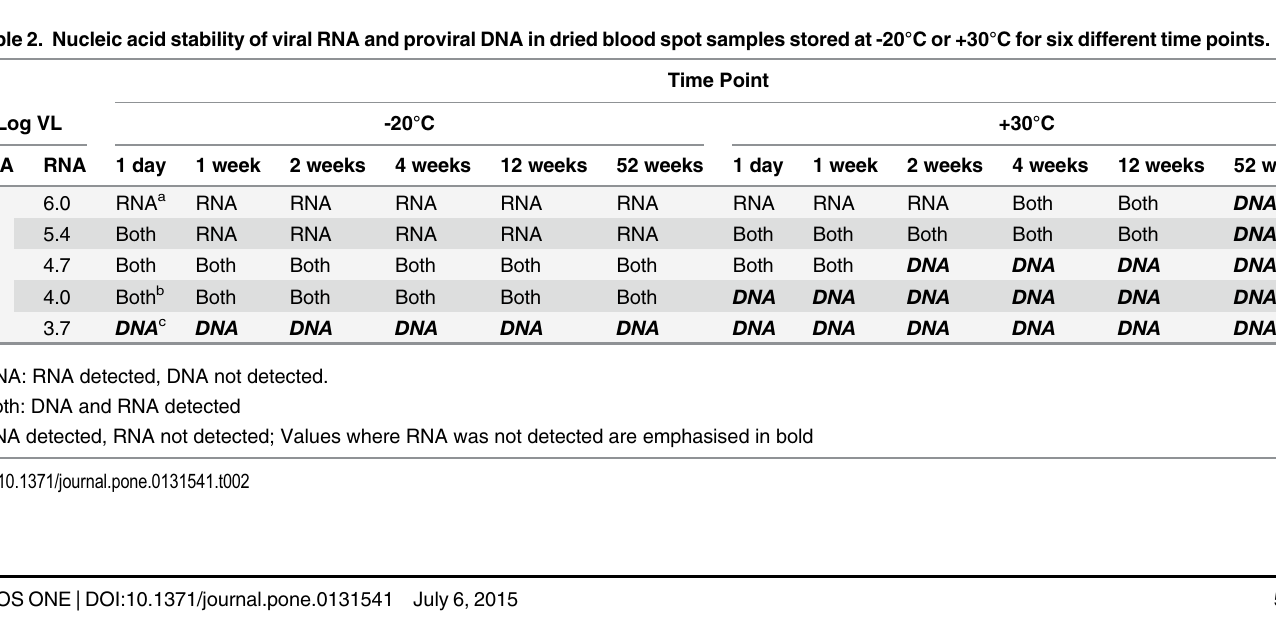
was no longer detectable at any of the concentrations tested (Table 2). To mimic field application of DBS collection, an experiment was performed in which short term storage at (elevated) room temperature was followed by storage at -20°C. Amplification of all DNA-RNA samples following sample storage for one day (baseline), one and two weeks at +30°C, followed by two weeks at -20°C, was successful for all samples. After four weeks stor- 3.0 RNA-only samples that age at +30°C, followed by two weeks at -20°C, none of the log 10 were stored at +30°C were amplified, whereas those stored at -20°C for the six weeks could all be successfully amplified. Genotyping of samples stored at +30°C for two weeks, followed by -20°C for another two weeks, demonstrated that the results were comparable to baseline results. After four week storage at +30°C, followed by two weeks at -20°C, the loss of RNA detection was notable at the highest VL concentration of DNA-RNA samples (Table 3).